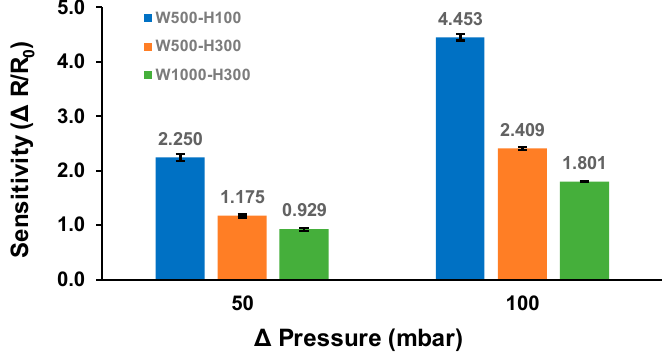
Figure 4. Comparison of the ICP sensor sensitivity among different designs ( n = 3).